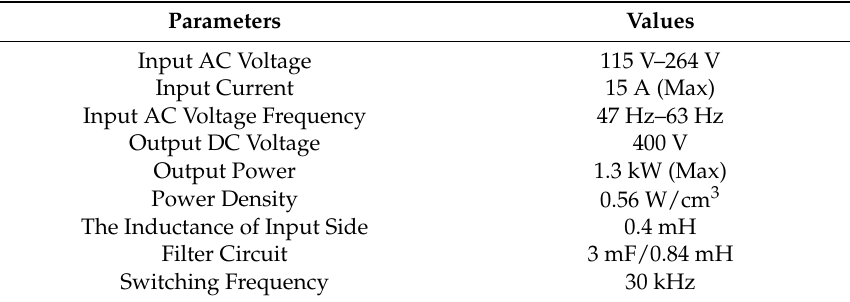
Table 3. System and control